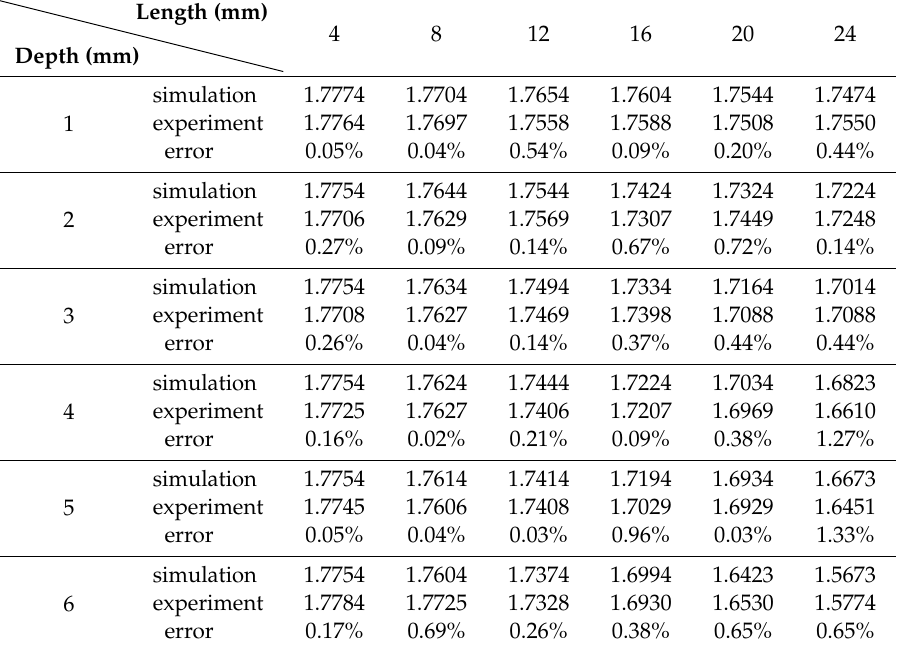
Table 9. Comparison of simulation and experiment data associated with the volumetric crack.